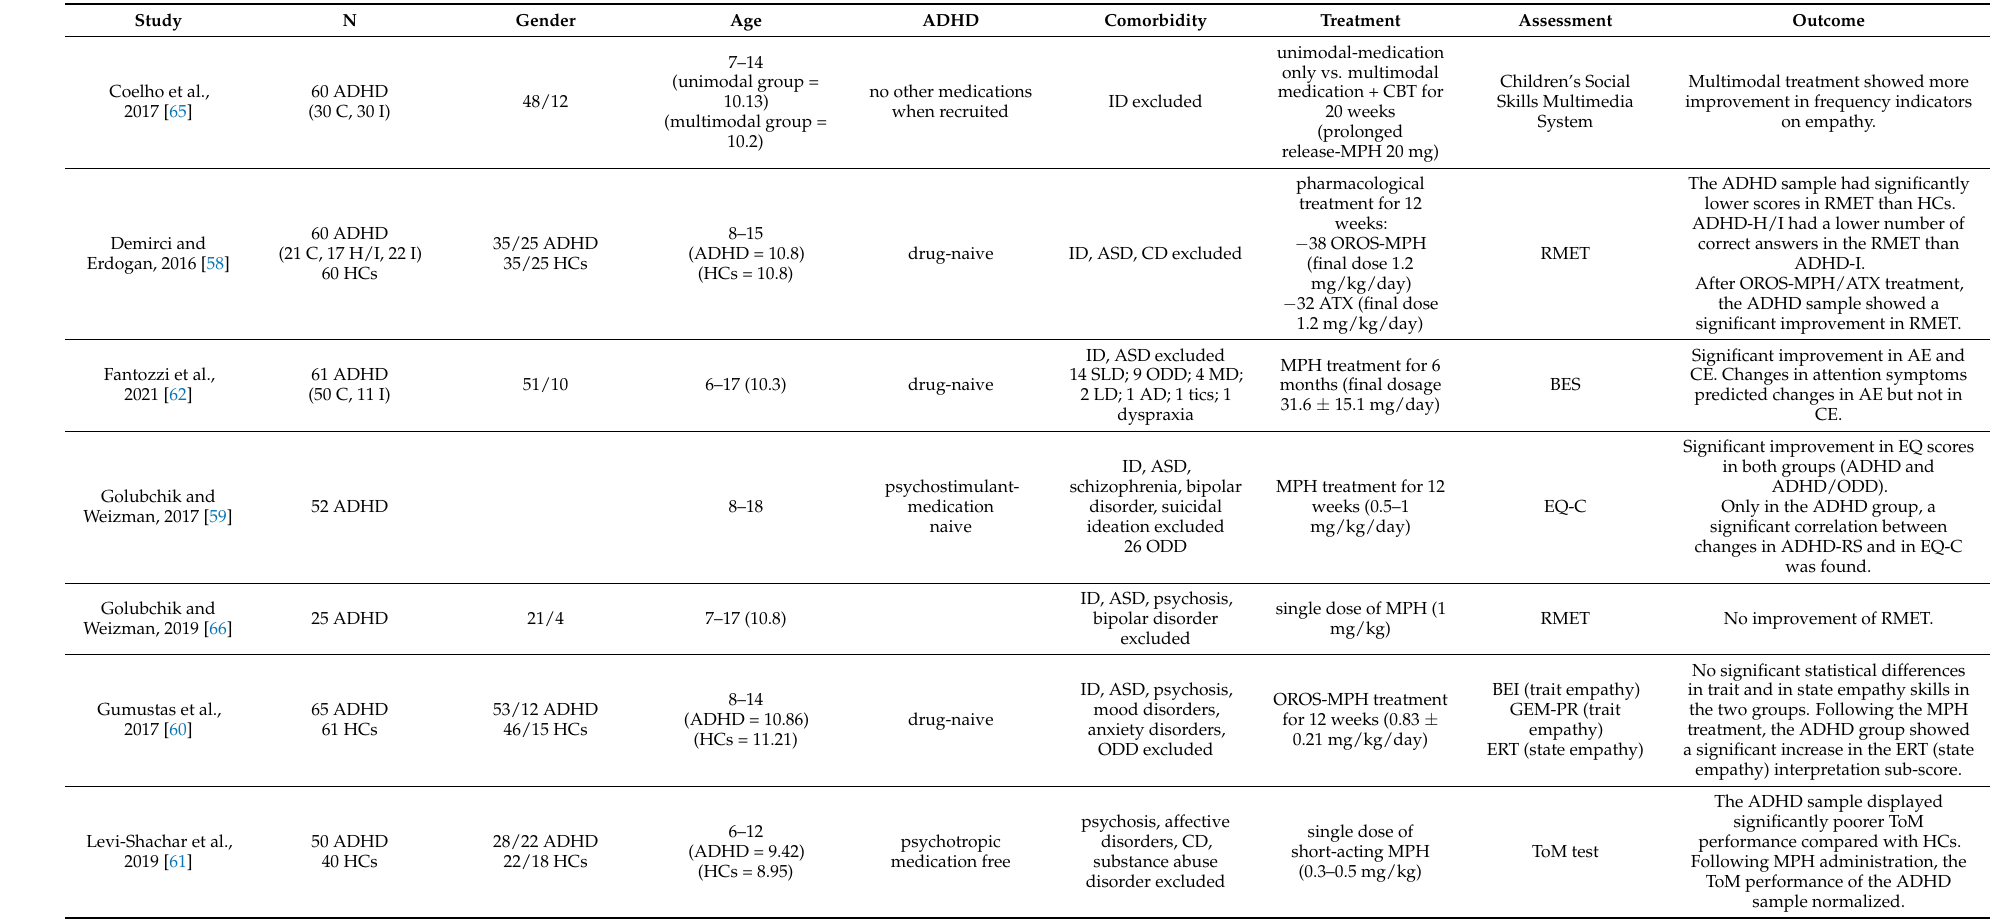
Table 1. Summary findings of the included studies: empathy and theory of